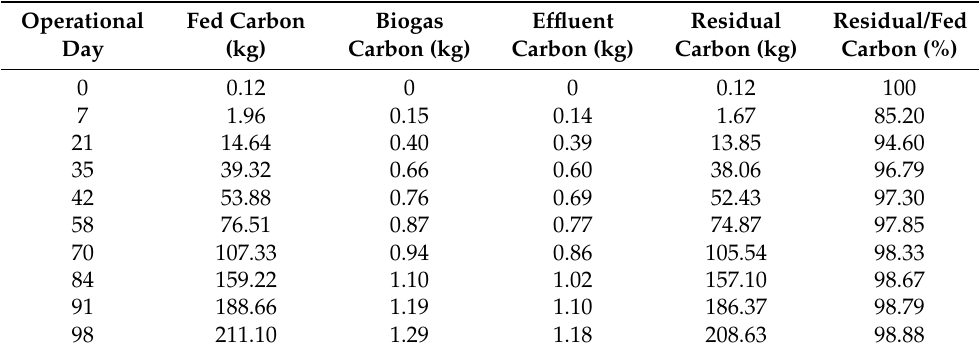
Table 3. Carbon mass balance during the AD